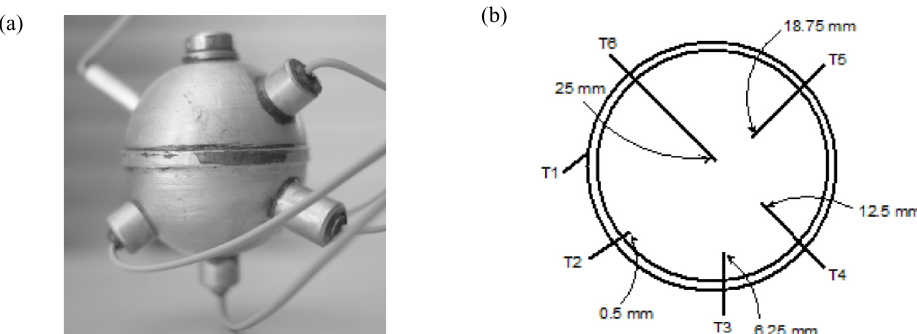
Fig. 1. (a) A photograph of the aluminium capsule. (b) A sketch of the cross-section of the aluminium capsule showing the positions of the thermocouples. Table 1. Measured values of some thermophysical properties of the In – 48Sn alloy.